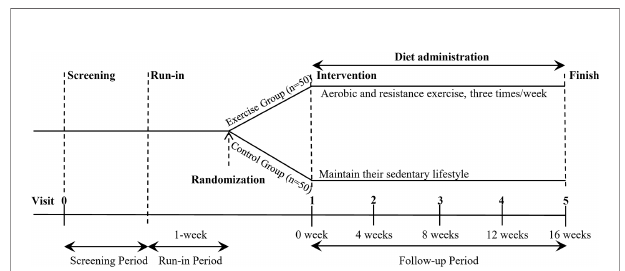
FIGURE 1 | Overview of the study design. After screening and a 1-week run-in period, eligible participants are randomly assigned to either exercise group or control group (n = 50 per group) for 16-week intervention. During the whole trial, participants in exercise group receive combined aerobic and resistance exercise training three times a week, and control group maintain their sedentary lifestyle unchanged. All participants receive a diet administration during the intervention. In addition, participants take part in a follow-up visit every four